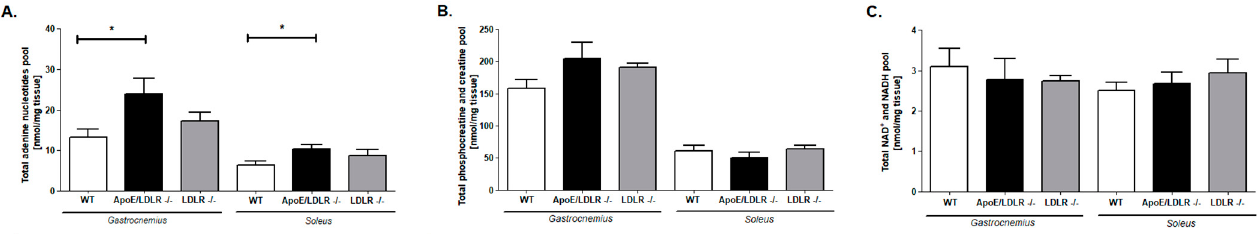
Figure 5. Elevated total adenine nucleotides pool in skeletal muscle of ApoE/LDLR -/- mice. Total adenine nucleotides ( A ), phosphocreatine and creatine ( B ), and NAD+ and NADH ( C ) pools in gastrocnemius and soleus of control (WT), ApoE/LDLR -/-, and LDLR -/-. Results presented as mean ± SEM, n = 4–8, * p < 0.05.